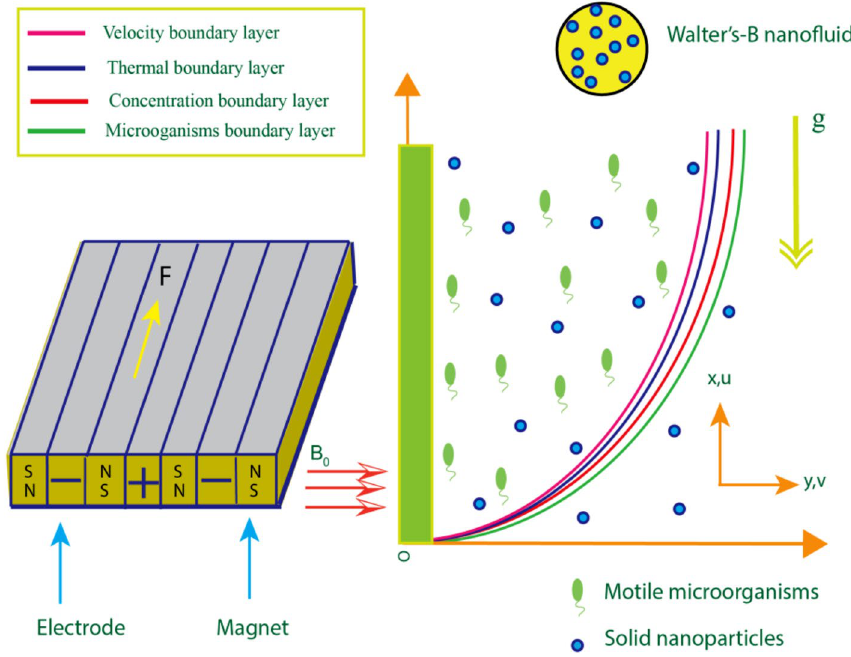
Figure 1. Flow chart for a current